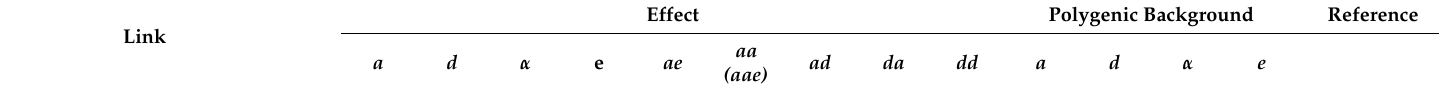
Effect Polygenic Background